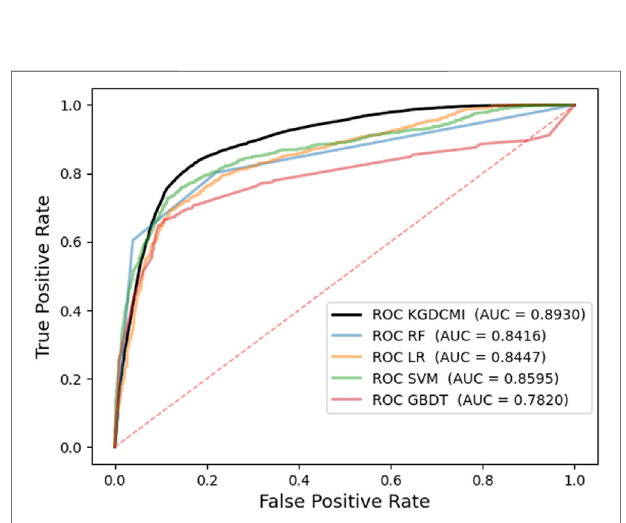
FIGURE 5 | Performance comparison of fi ve traditional classi fi ers and DNN in terms of